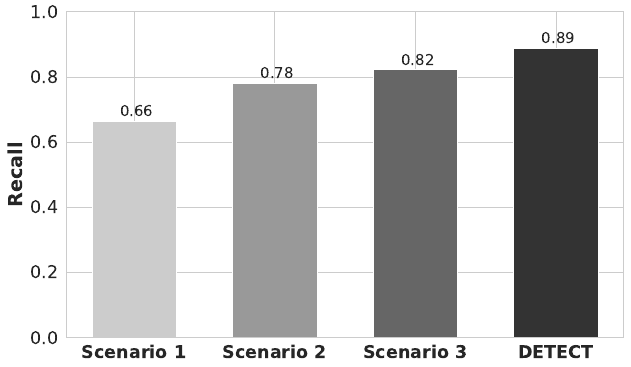
Figure 9. Recall results for each scenario of data